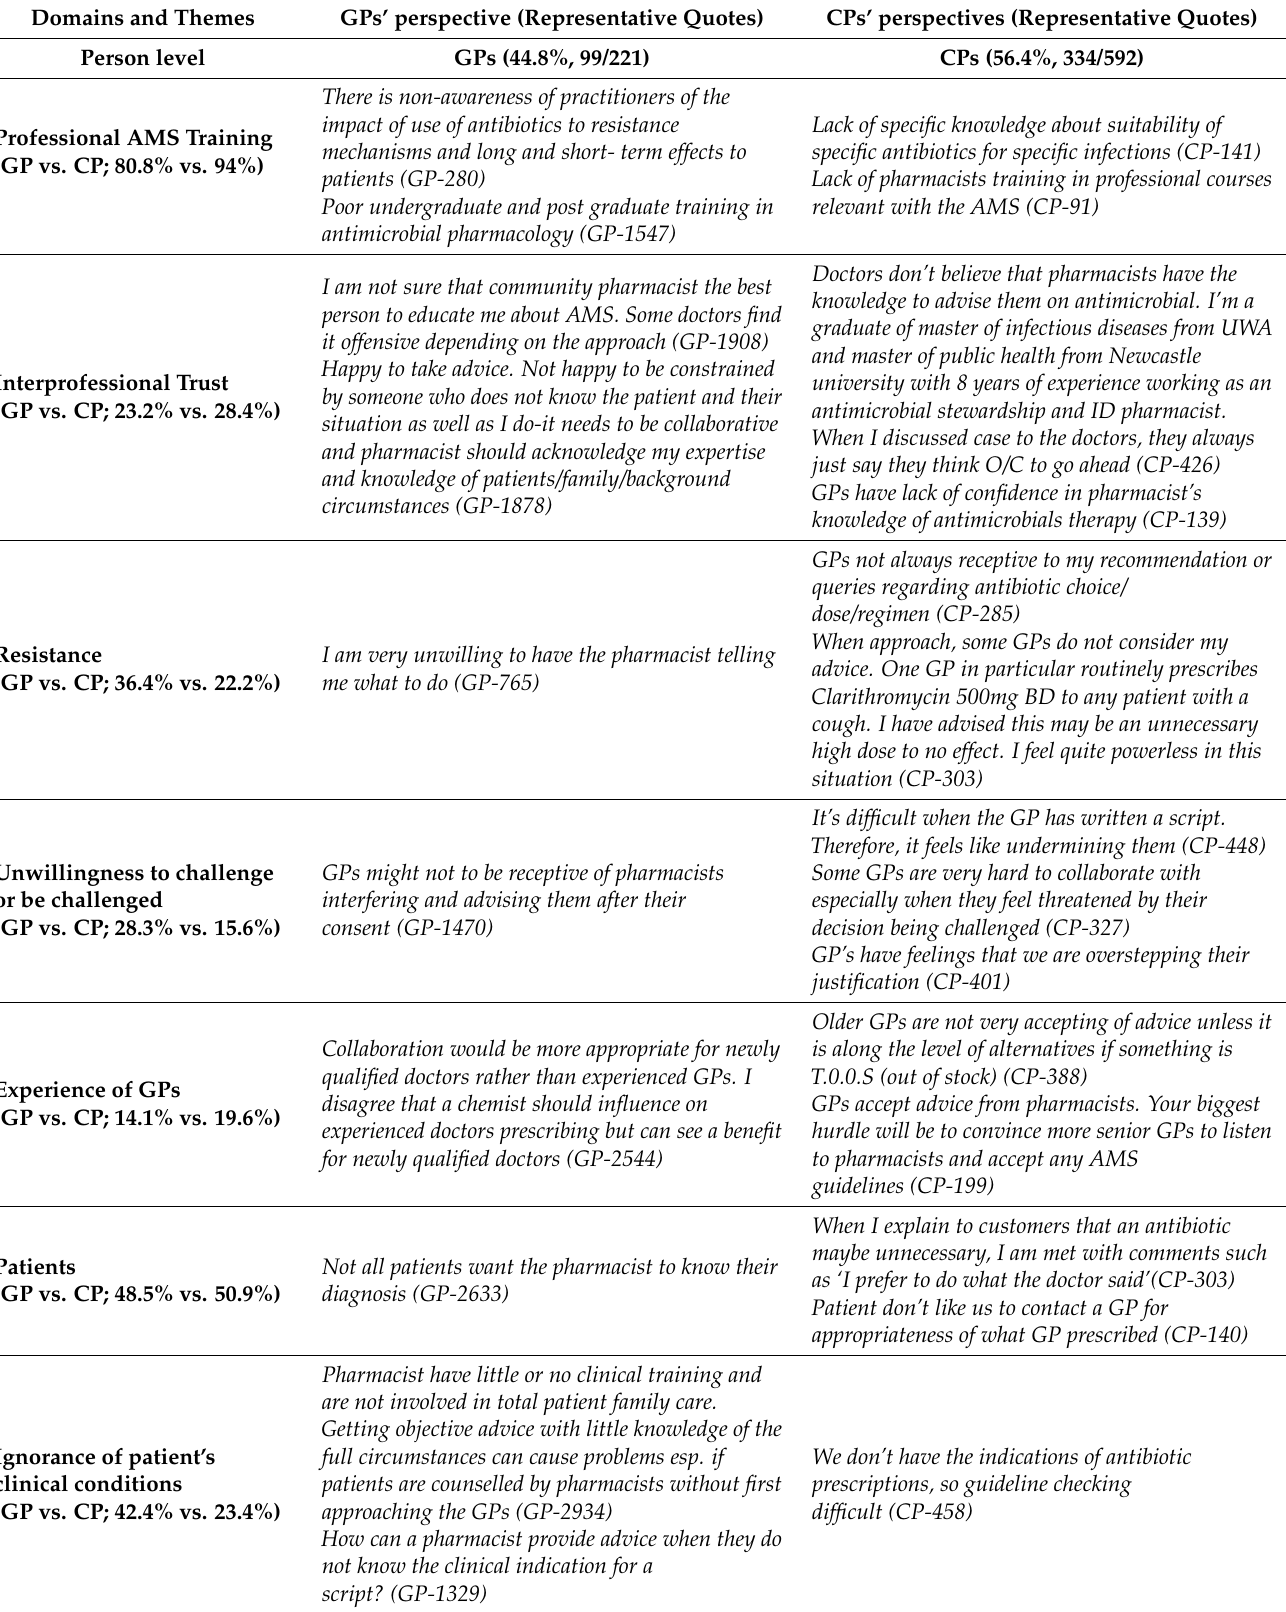
Table 3. Barriers and challenges of AMS implementation by GP–pharmacist